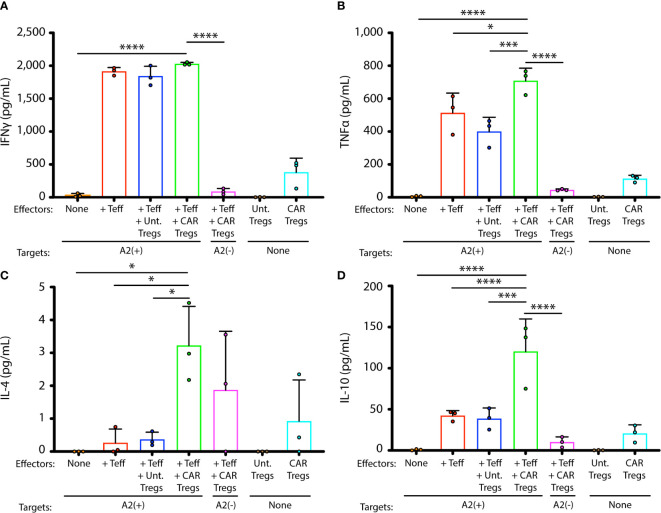
GD3 CAR Tregs generate immunosuppressive cytokines in presence of activated T cells. Cytokines were measured in supernatants from cocultures of melanocyte targets and HLA-A2-restricted Teffs, in presence and absence of untransduced or CAR-transduced Tregs. Cytokine concentrations for each coculture, measured in triplicate cocultures, are shown for (A) IFN-γ, (B) TNF-α, (C) IL-4, and (D) IL-10. Statistical analysis was performed by a one-way ANOVA test followed by Tukey’s post-hoc test for multiple comparisons. *p < 0.05; **p < 0.01; ***p < 0.001; ****p < 0.0001.